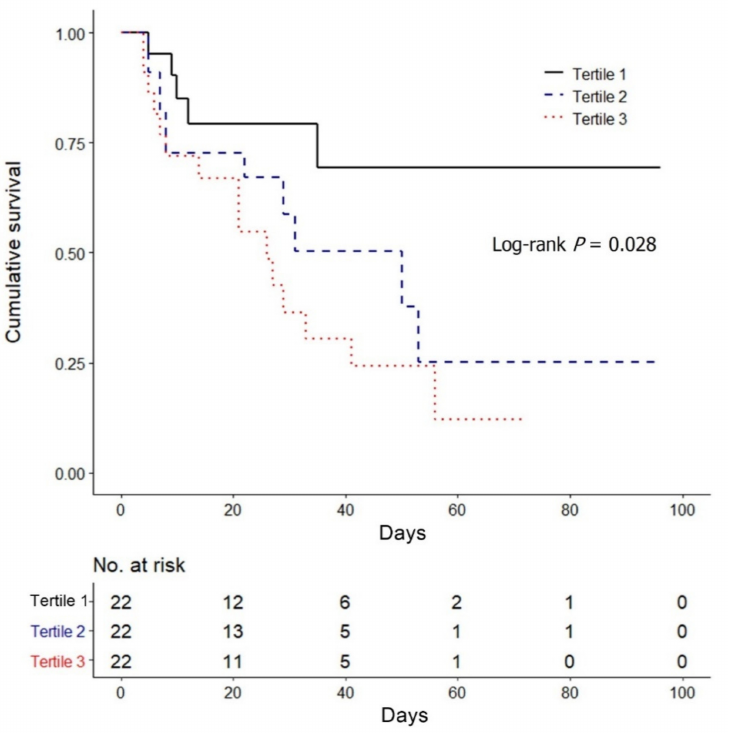
Figure 3. Kaplan–Meier survival curve for in-hospital mortality by GDF-15 tertiles. Abbreviation: GDF-15, growth differentiation